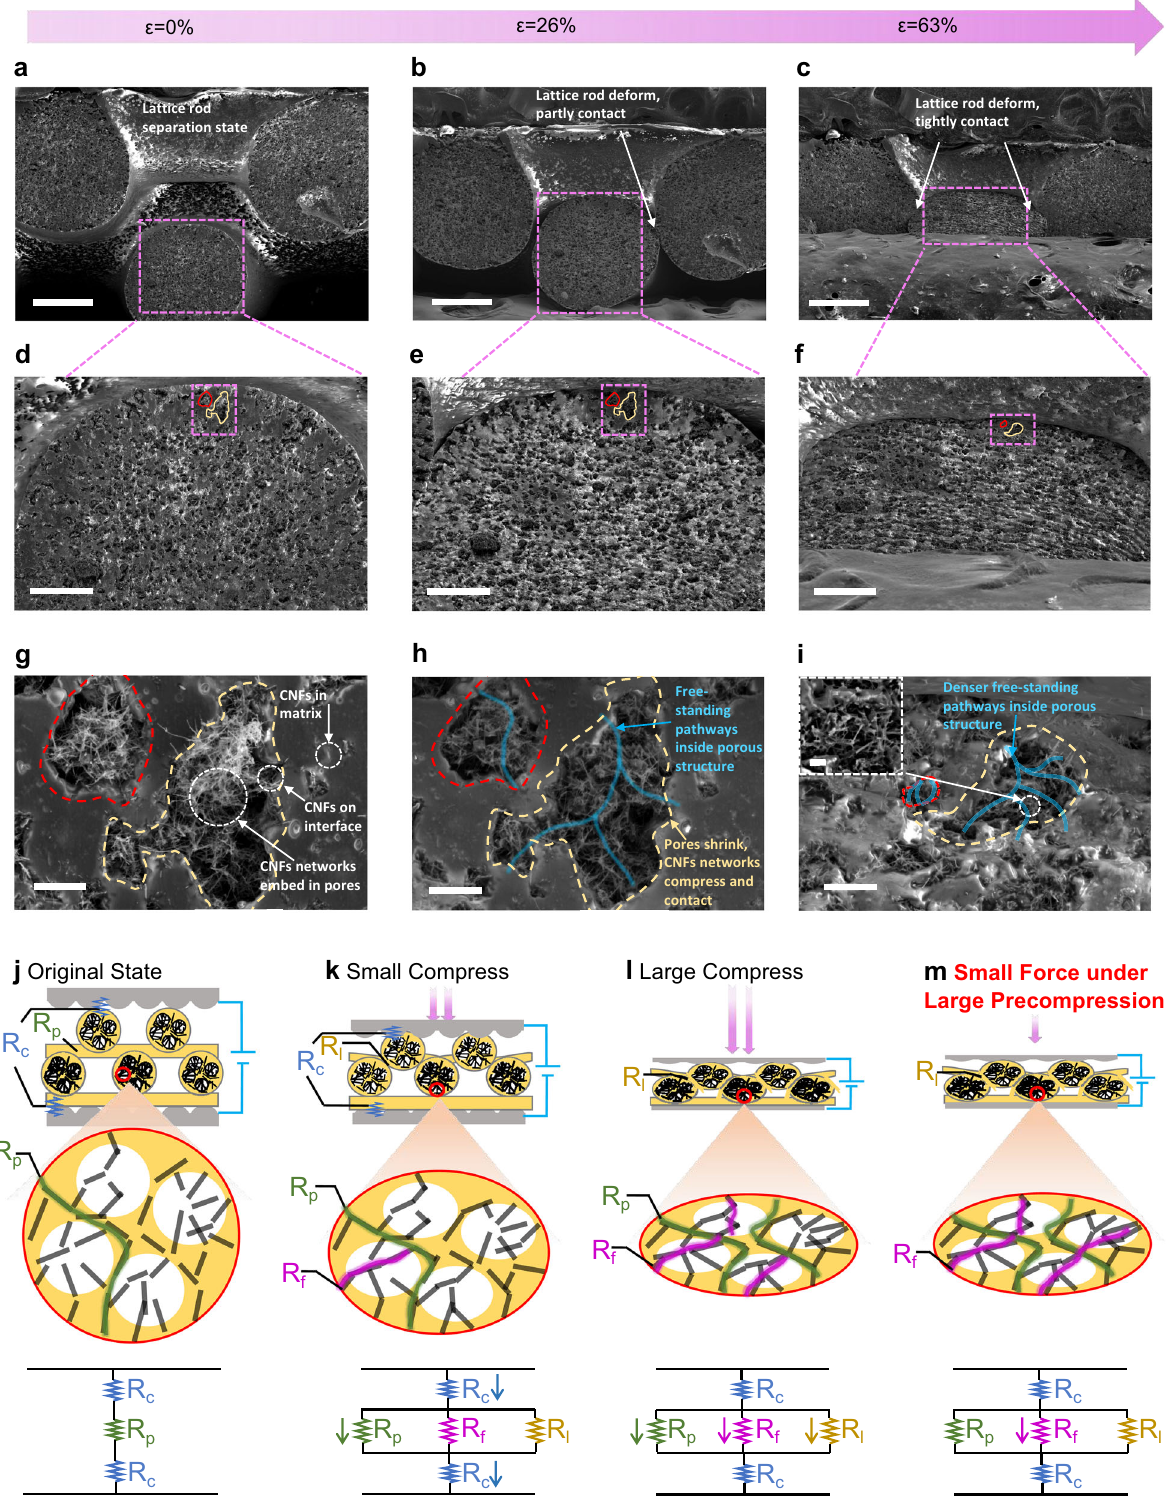
Fig. 4 In-situ SEM images of structural deformation of hierarchical in-situ fi lling porous structure during compression and schematic description of sensing mechanism. Cross-sectional SEM images of lattice structure at a original state, b compression of 26%, c compression of 63% (scale bar: 300 µm). Cross-sectional SEM images of the porous structure at d original state, e compression of 26%, f compression of 63% (scale bar: 100 µm). Cross-sectional SEM images of the CNFs networks embedding in a single pore at g original state, h compression of 26%, i compression of 63% (scale bar: 10 µm; i inset image scale bar: 3 µm). Schematic illustration and circuit diagram of sensing mechanism of HPPS under j small compression, k medium compression, l large compression. m A tiny pressure change under a large preload is used to illustrate the high pressure resolution